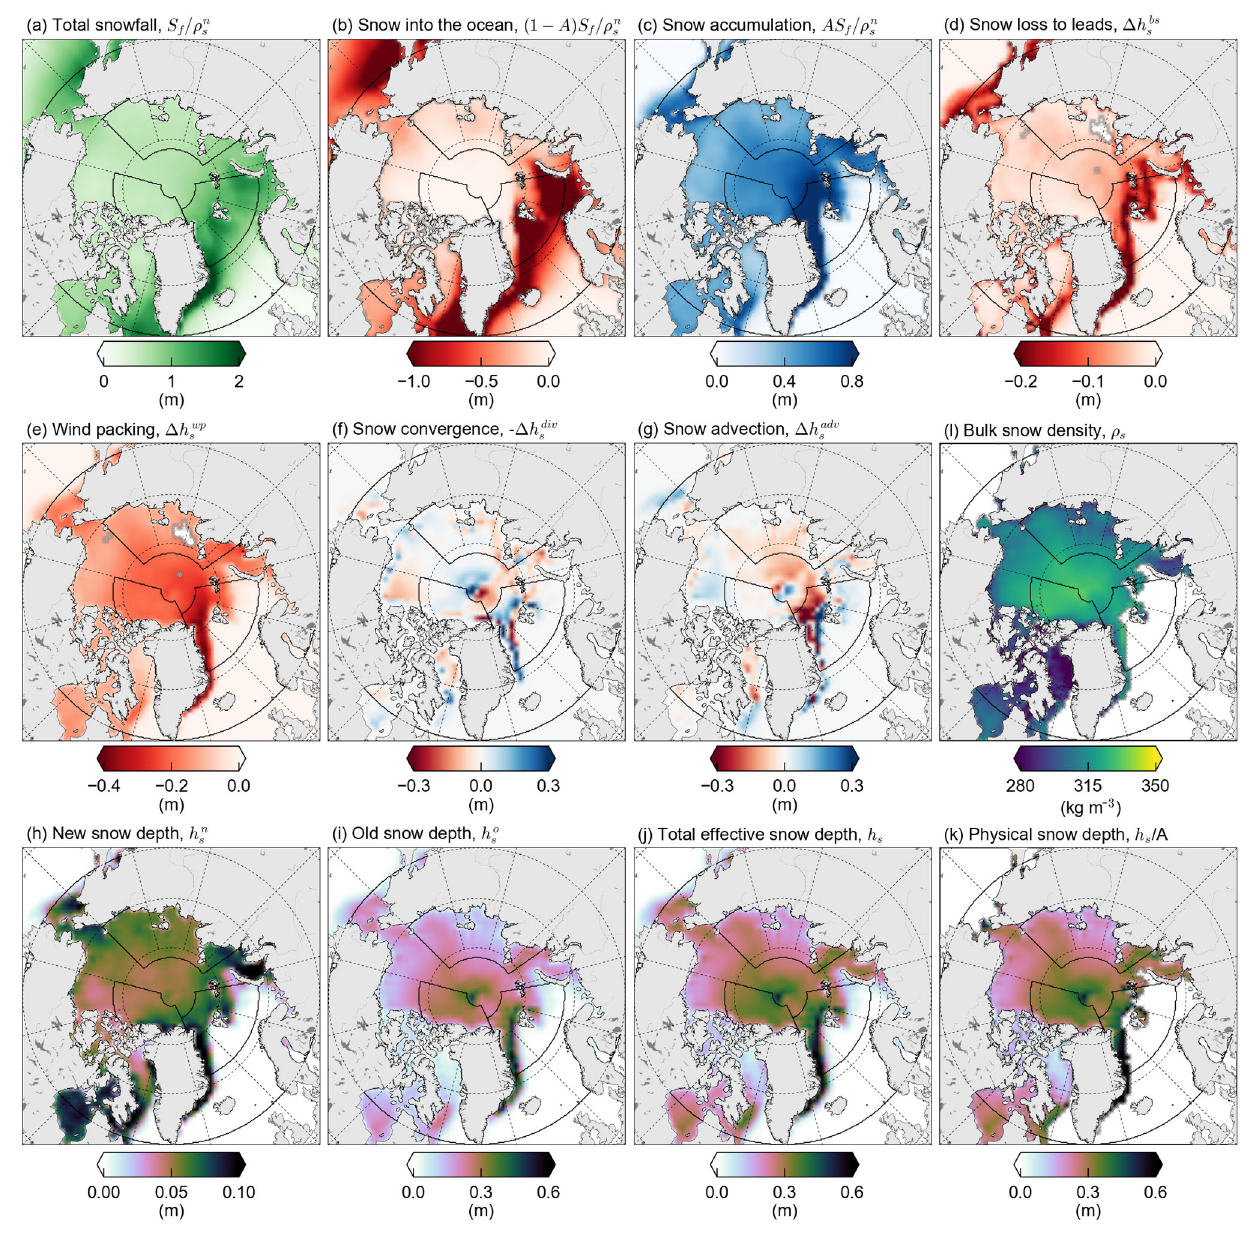
Figure 8. Snow budget terms as of 1 May, averaged over the 2001 to 2015 time period using the default/MEDIAN-SF NESOSIM simulations. The black lines show the four study regions used throughout this study. Panels (a) to (g) are integrals from the 15 August start date. Note the different color bar scales in panels (h) to (k)